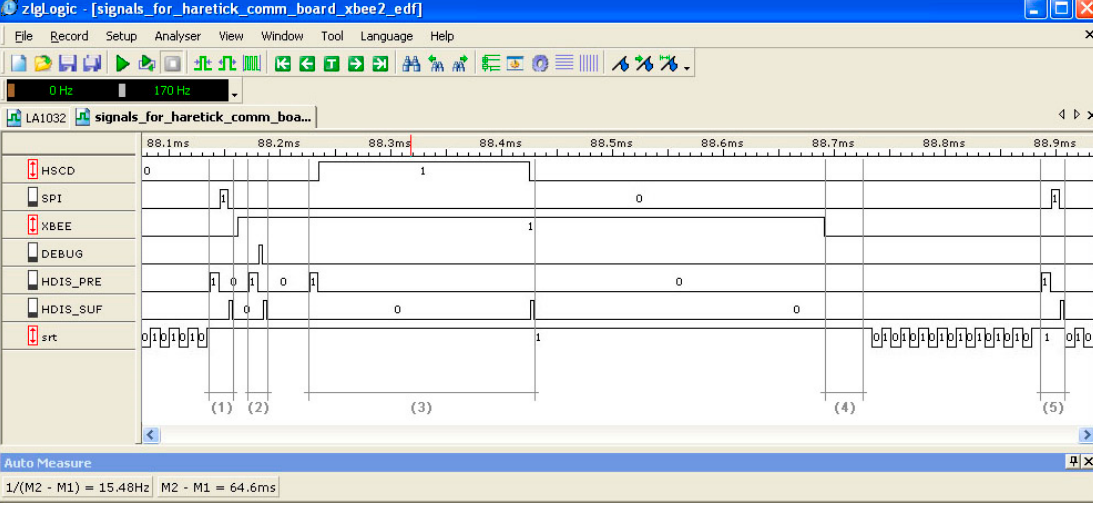
Figure 11. Operation of the XBee-based wireless board, captured with the logic analyzer.